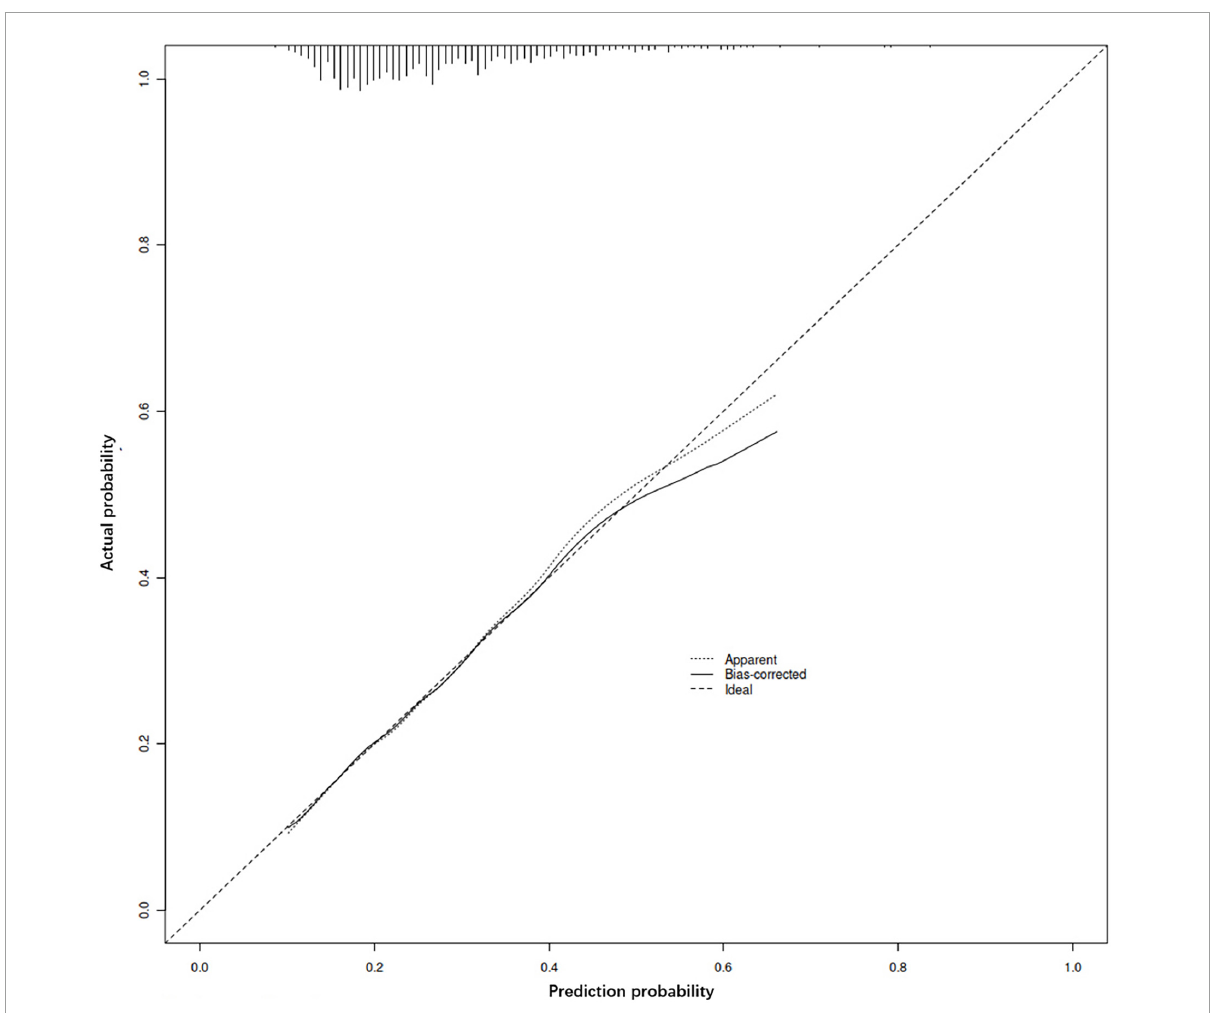
FIGURE3 Calibration curve of the prediction model. The accuracy of the model is judged by observing the coincidence between the prediction probability of random sampling and the actual situation.